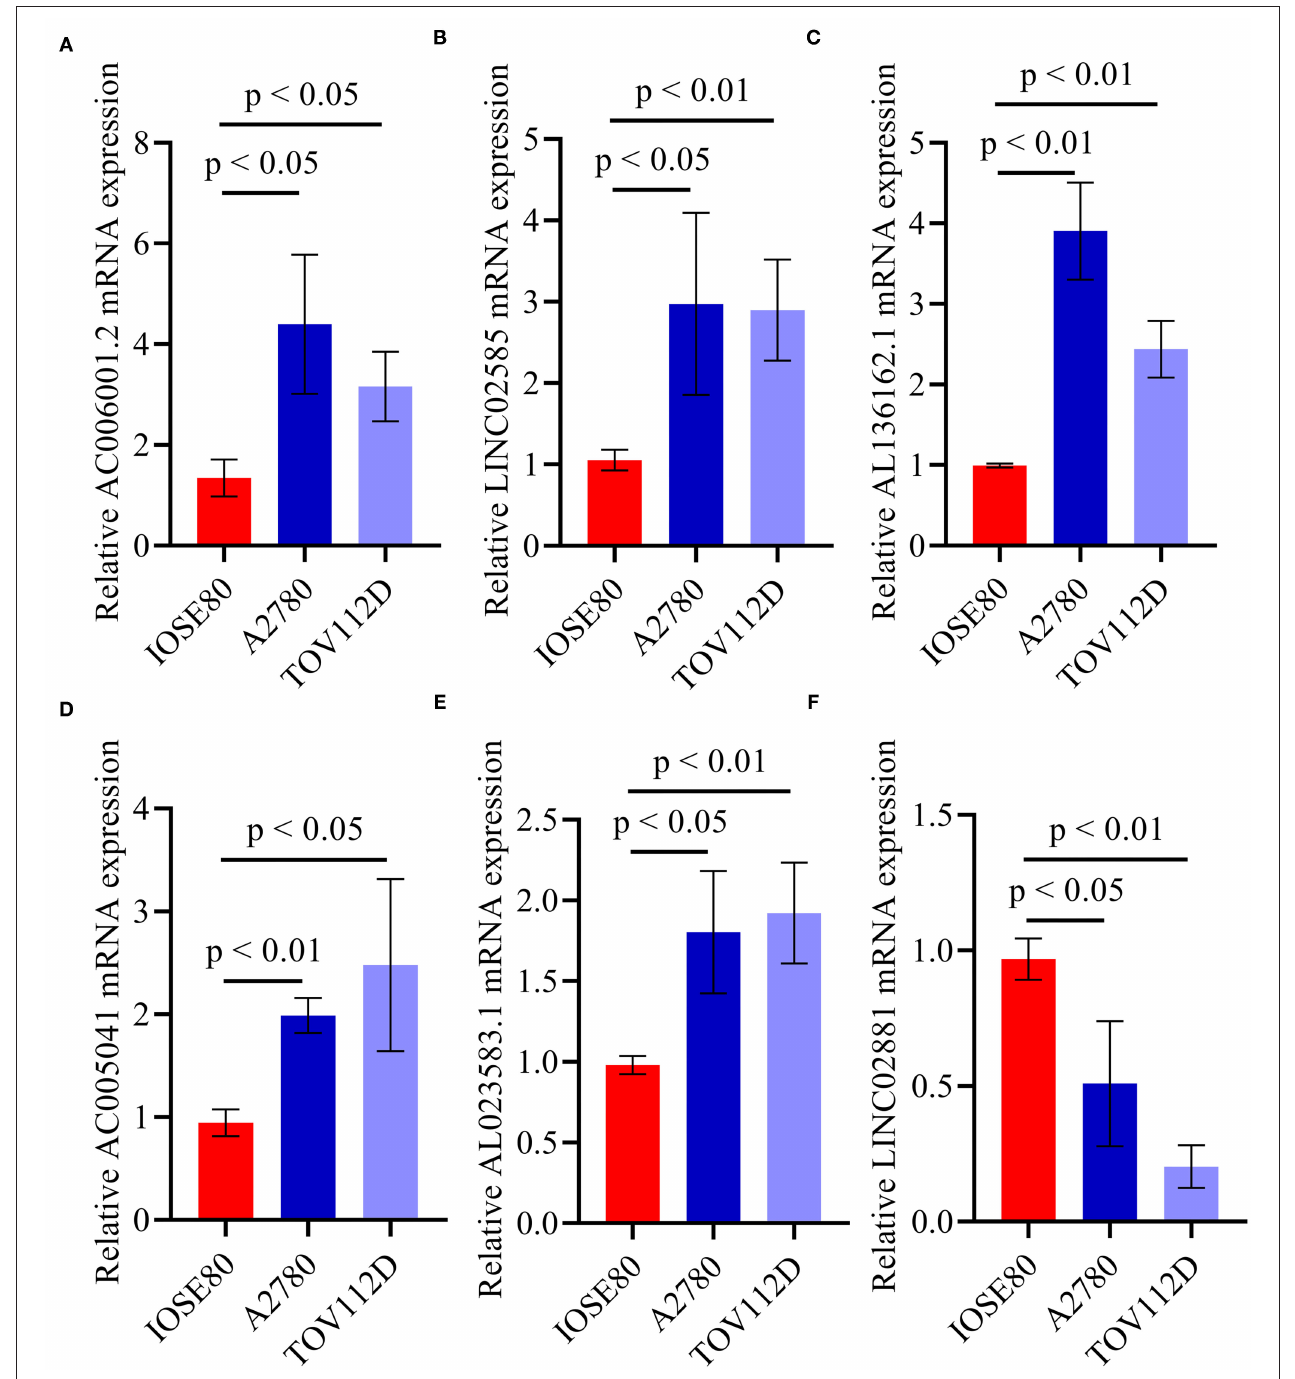
FIGURE 7 | qRT-PCR of the six identified pyroptosis-related lncRNAs. (A) AC006001.2. (B) LINC02585. (C) AL136162.1. (D) AC005041.2. (E) AL023583.1. (F)